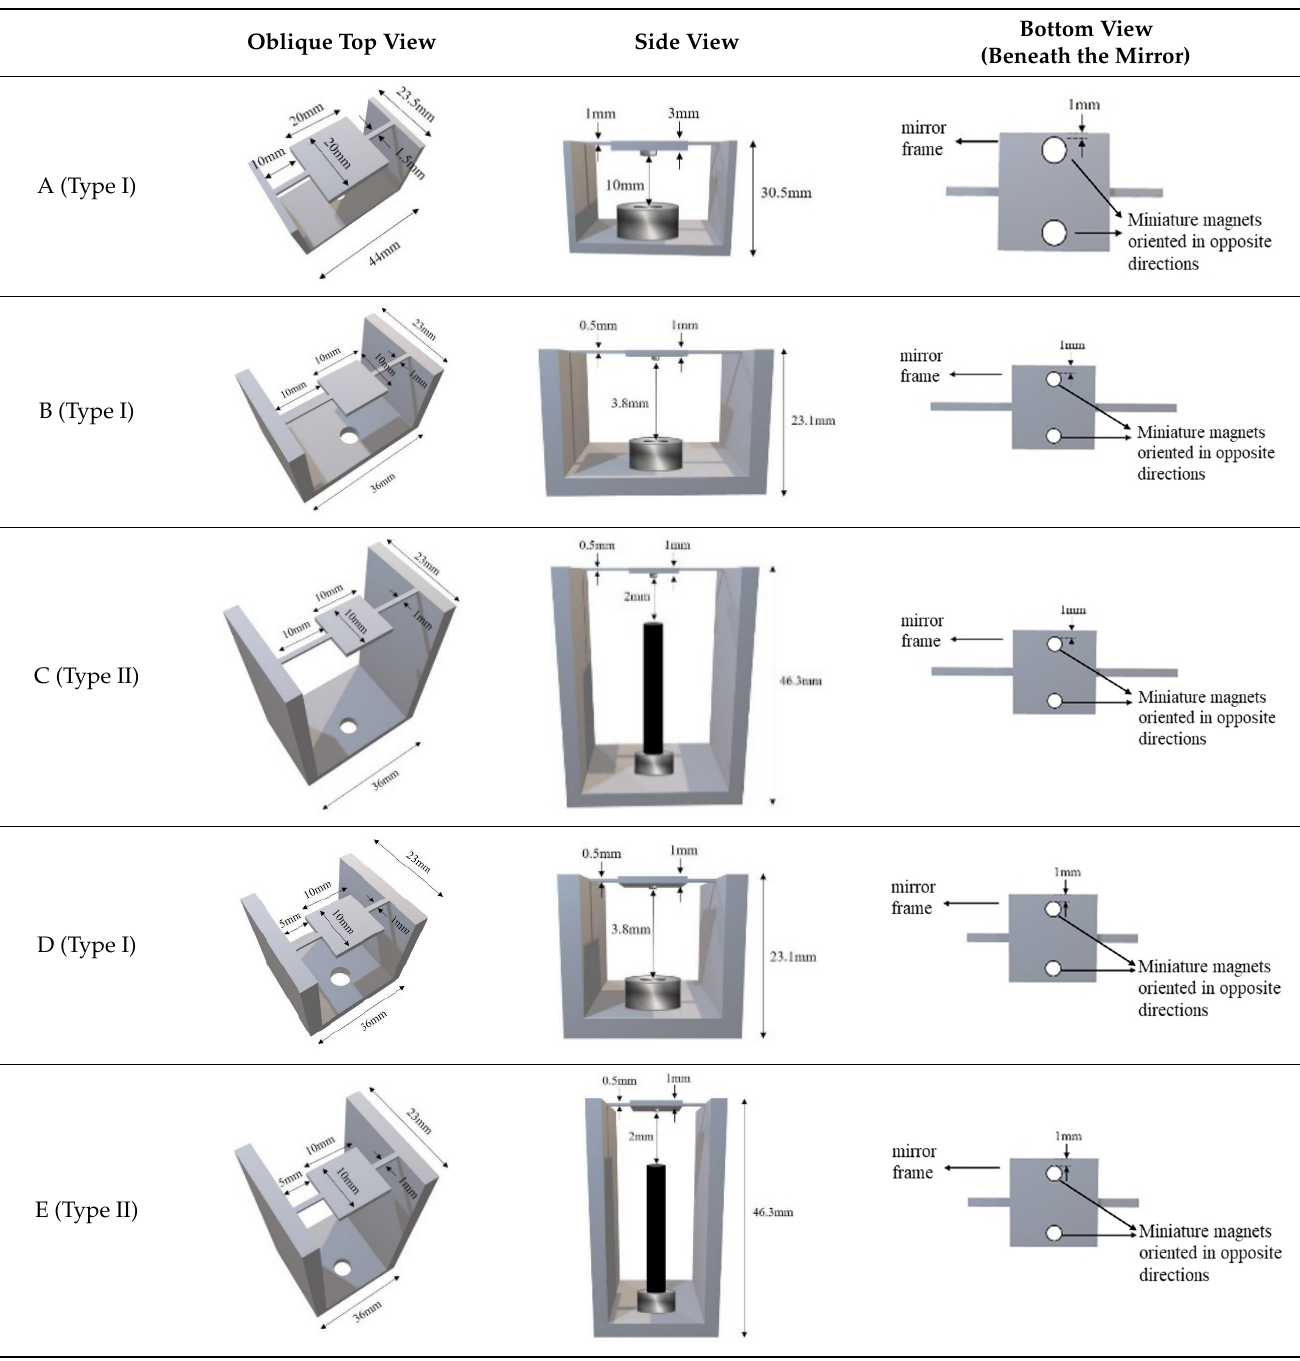
Table 1. Schematic 3D drawings and designed dimensions of the five different designed devices.